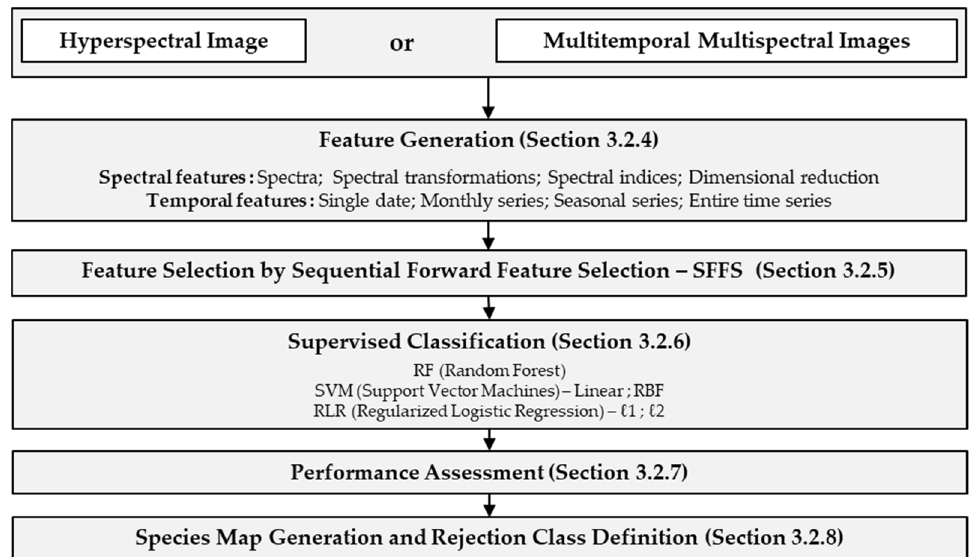
Figure 3. General classification method flowchart.